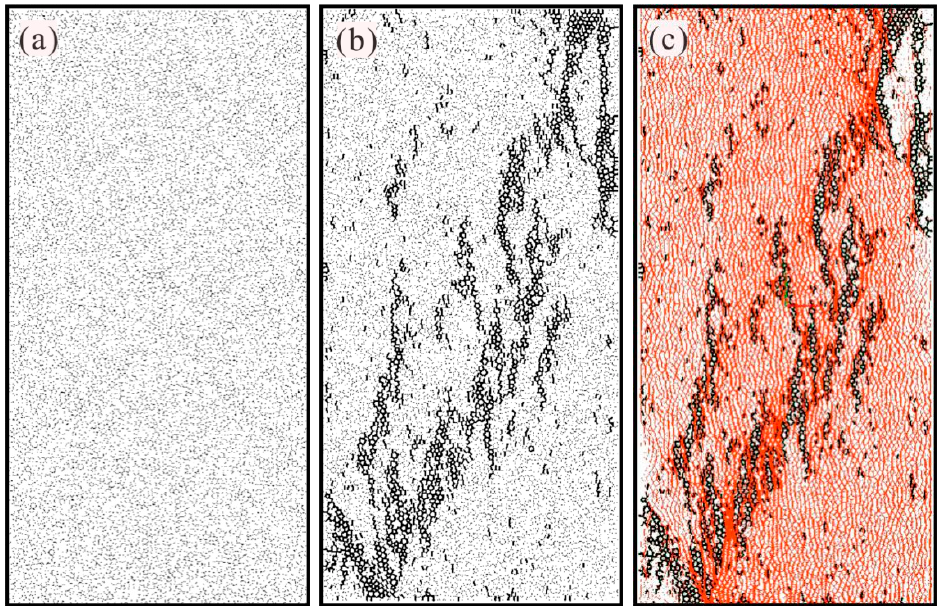
Figure 6. Numerical model and simulation results of uniaxial compression test: ( a ) before destruction; ( b ) after destruction; and ( c ) distribution of the force chain. Table 2. Parameters of numerical simulation.